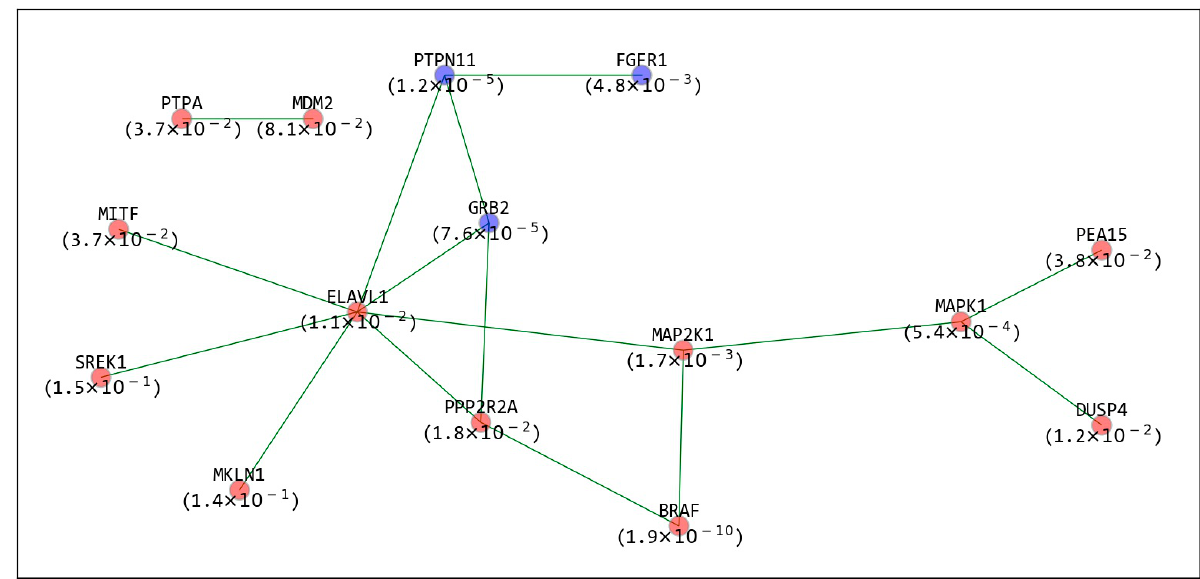
Figure 6. SPN1 for mutated BRAF based on PPI networks from CRISPR screening. The red and blue nodes are the SPs associated with GIs sensitive and resistant to mutated BRAF , respectively. SPN1 includes only the SPs that adjoin each other. SPN: synthetic partner network.